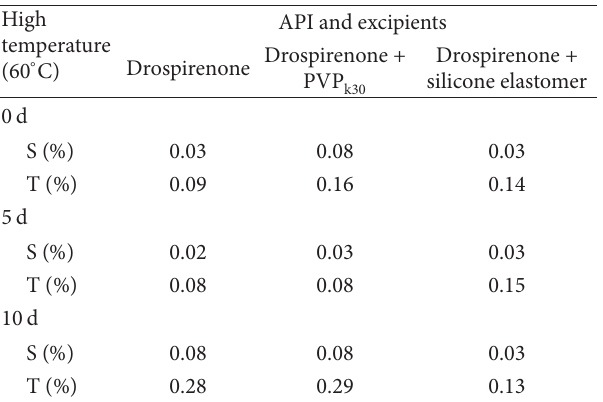
T 6: e results of API excipients compatibility testing under high temperature.